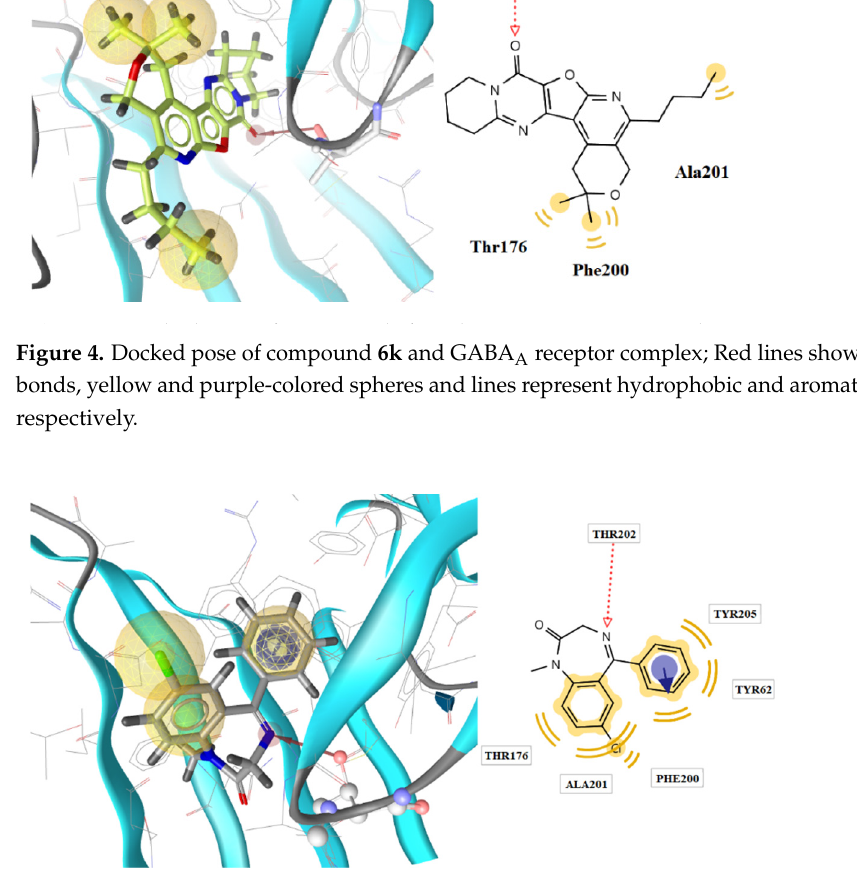
Table 8. Molecular docking scoring function that estimates free energy of binding (kcal/mol) in SERT transporter (PDB ID: 3F3A) .